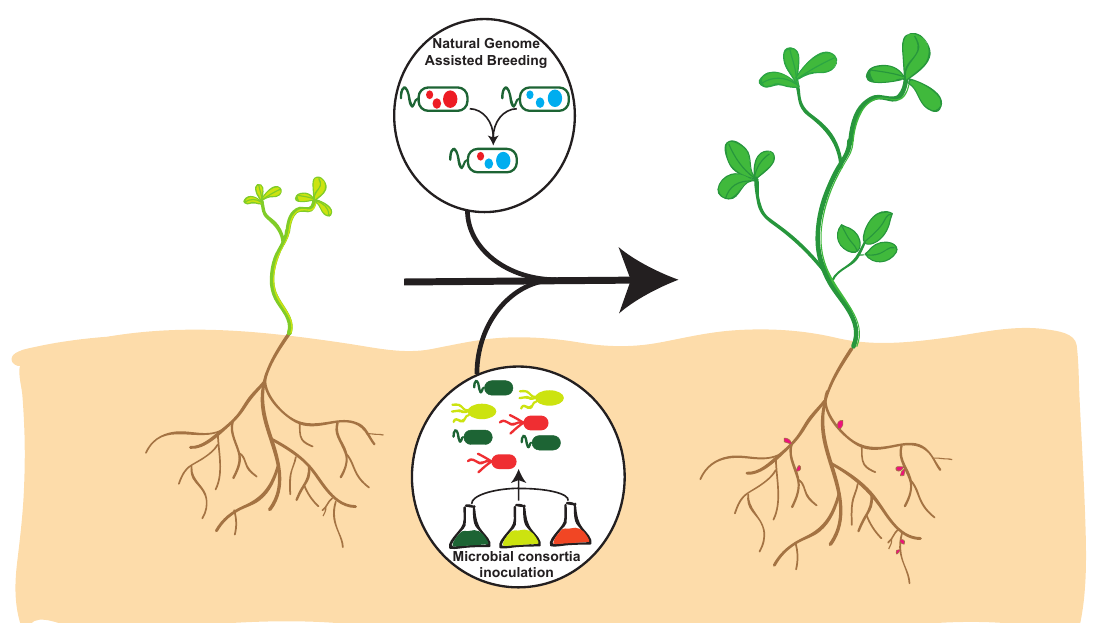
Figure 2. Di ff erent approach aimed to promote plant growth: Natural genome assisted breeding as a genomic manipulation strategy, and microbial consortia (multi-strains combination) for the improvement of plant-specific rhizobial inoculants in harsh